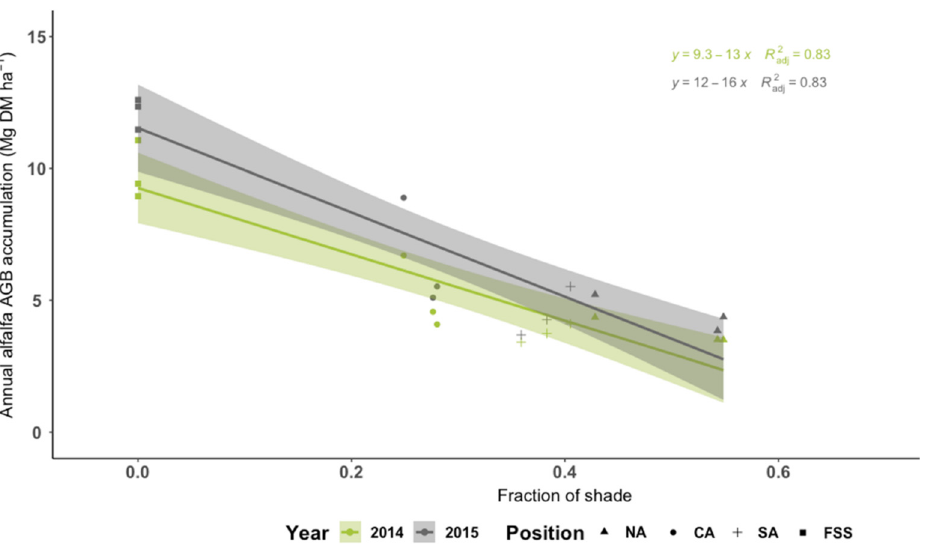
Figure 4. Linear regression of annual alfalfa above-ground biomass (AGB) accumulation in 2014 and 2015 with fraction of shade at the herbaceous layer. Colored lines indicate linear models and green and grey shades indicate standard error bounds for 2014 and 2015 data: NA means north-facing side, CA means central part, and SA means south-facing side of the alley, while FSS means alfalfa of the full-sun system.